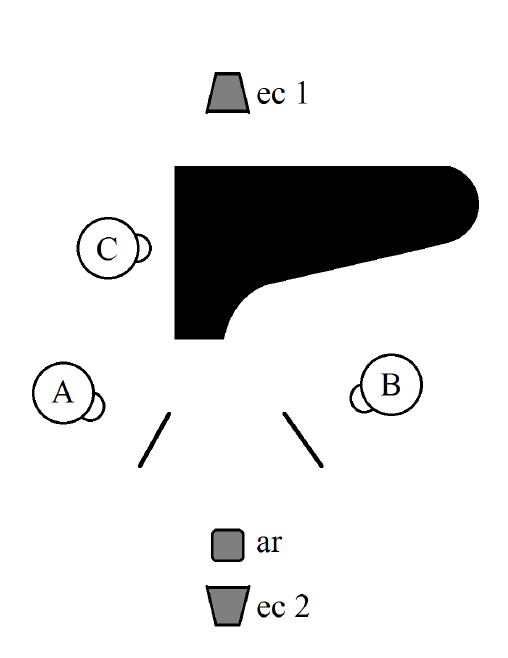
Figure 1. Plan of the set-up, indicating the positions of the violinist (A), clarinetist (B), pianist (C), external camera on the balcony (ec1), external camera in the seating area (ec2) and audio recorder on the front row of the seating area (ar). The large black object represents the grand piano, while the two black lines indicate the music stands of the violinist and